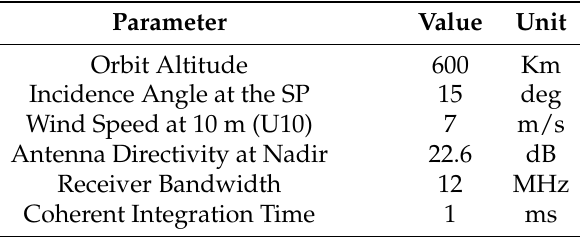
Table 2. Parameters For